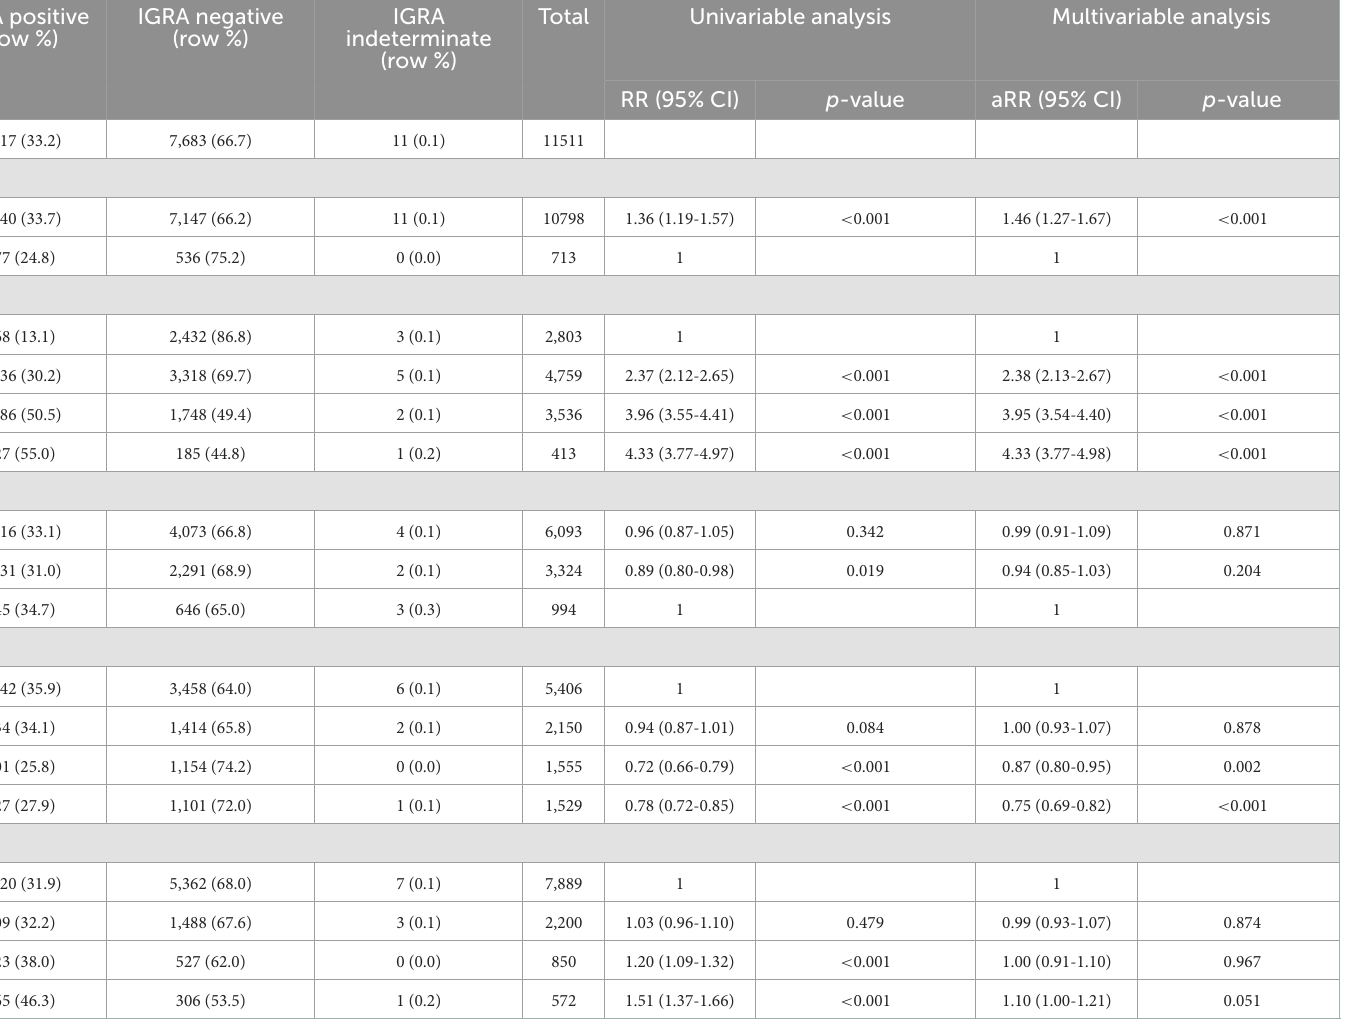
TABLE 4 Prevalence of LTBI in Group C (inmates of correctional facilities) and risk factors for LTBI.